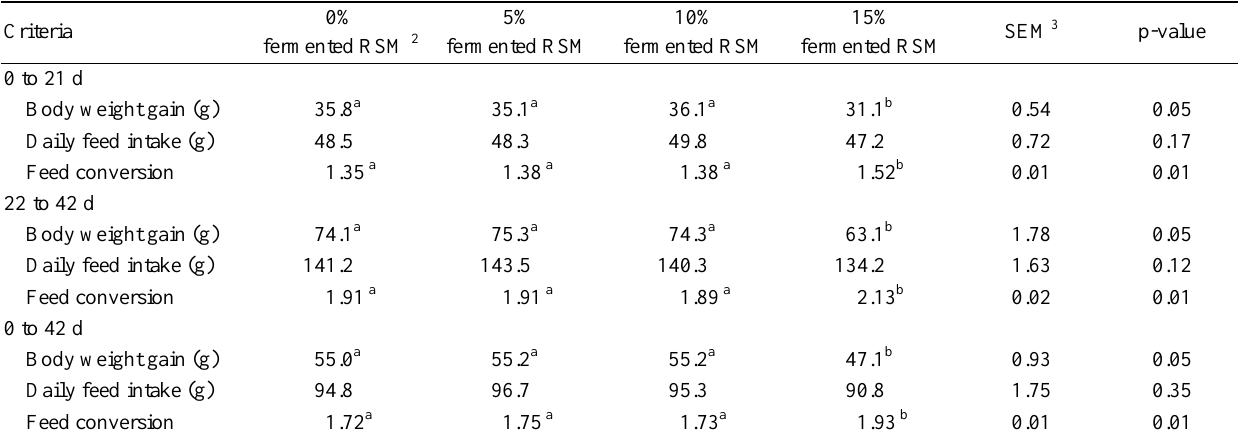
Table 3. Effect of fermented RSM on growth performance of broilers 1